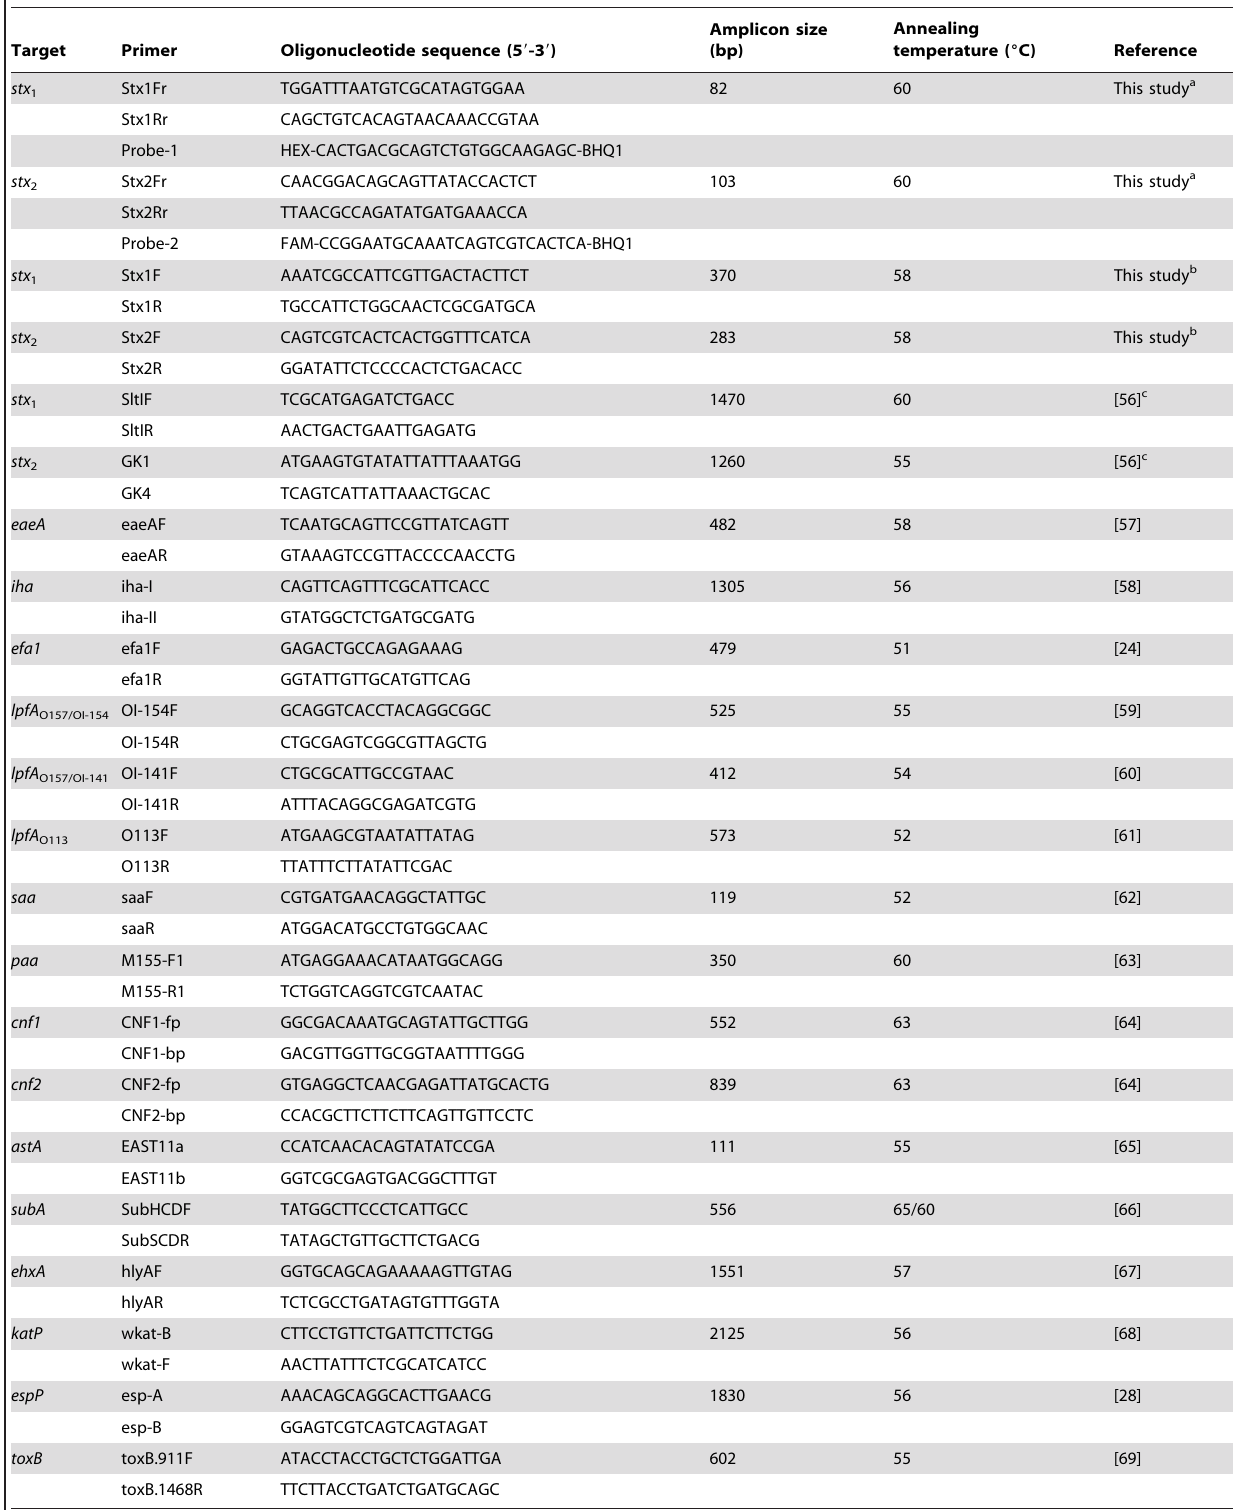
Table 1. PCR primers used for the detection of STEC virulence or adherence